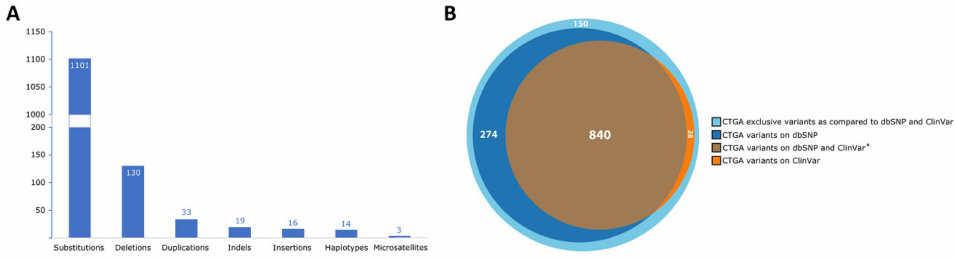
Figure 4. CTGA variant records reported in Lebanese subjects. ( A ) Distribution of types of 1316 CTGA variant records reported in Lebanese subjects. ( B ) Cylinder Venn distribution of CTGA variant records reported in Lebanese subjects relative to dbSNP and ClinVar variant databases (last updated 14 June 2021). * 24 of the 1316 variants were omitted due to disparate modes of classification between dbSNP and ClinVar, involving multiple distinct variants at the same position as well as